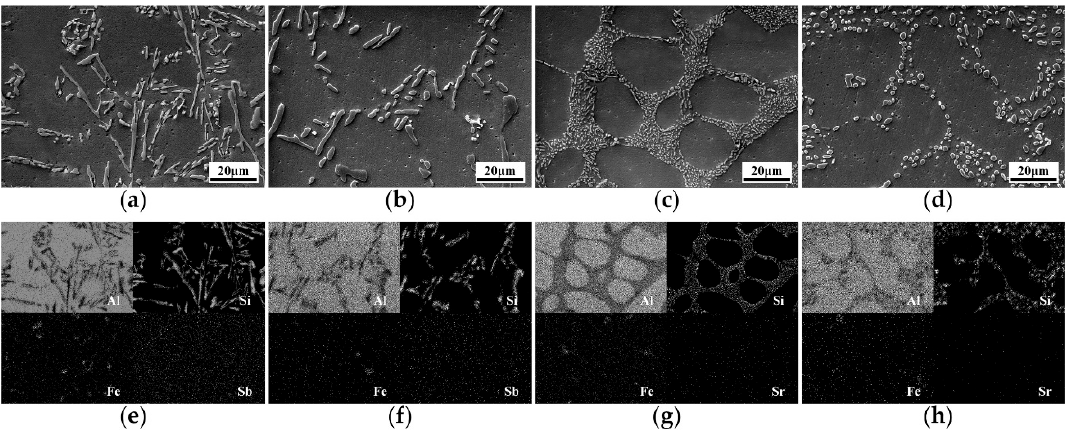
Figure 5. ( a – d ) Scanning electron microscope (SEM) micrographs and ( e – h ) energy dispersive spectrometry (EDS) of Al-8Si alloys in different states: ( a ) 0.5 wt.% Sb, ( b ) 0.5 wt.% Sb + T6, ( c ) 0.12